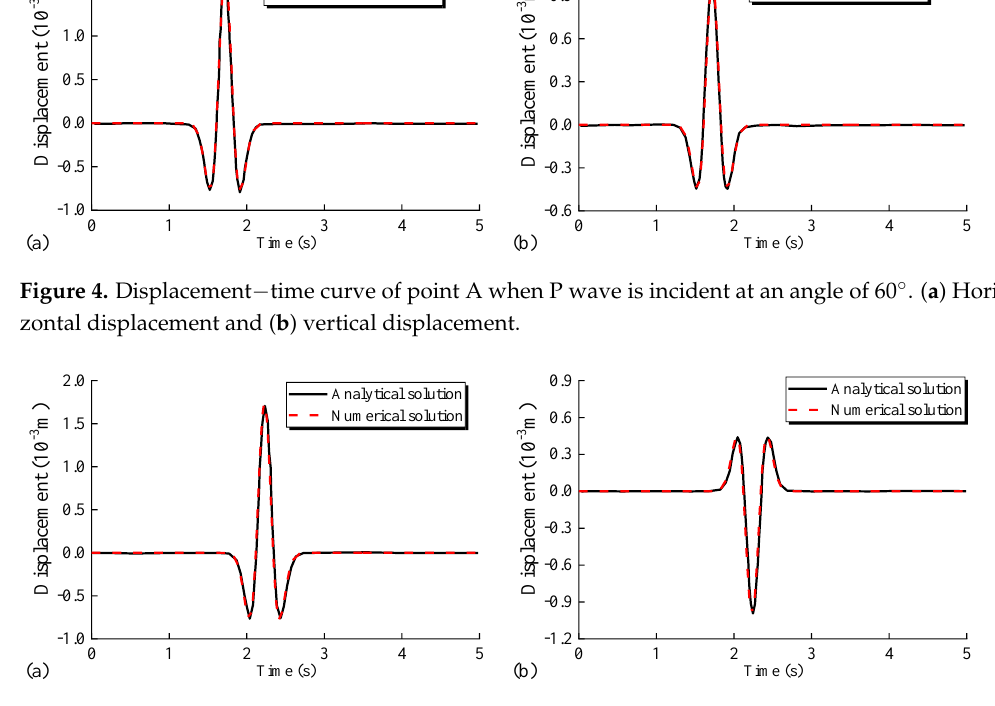
Figure 5. Displacement−time curve of point A when SV wave is incident at an angle of 30 °. ( a ) Horizontal displacement and ( b ) vertical displacement.